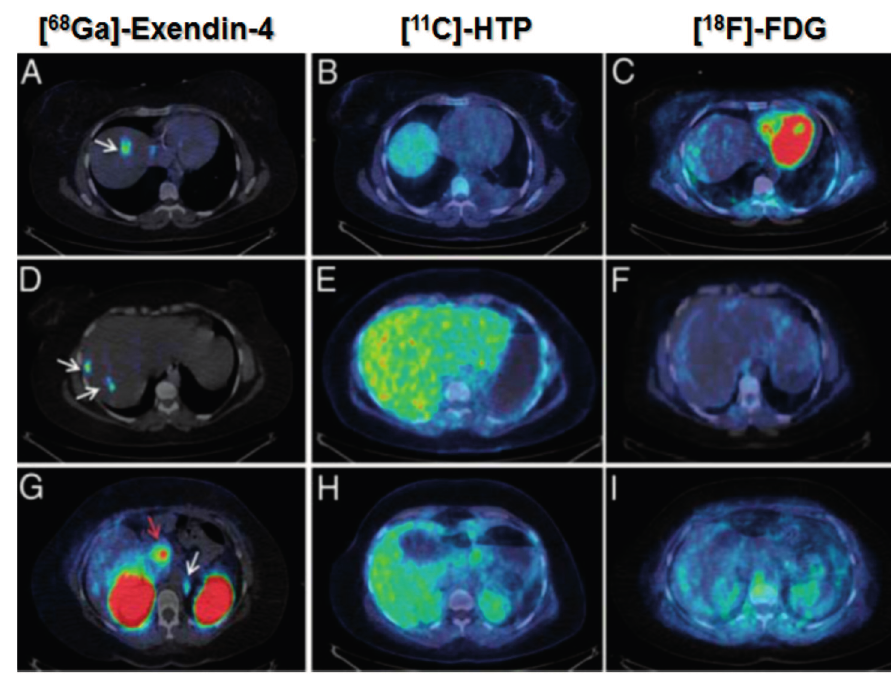
Figure 19. [ 68 Ga]Ga-DO3A-Exendin-4/PET-CT revealed several GLP-1R positive lesions (white arrows) in the liver ( A , D ) and a paraortallymph node ( G ). Beta cells in normal pancreas (red arrow) have significant expression of GLP-1R and can also be visualized by this technique ( G ). No pancreatic or hepatic lesions could be detected by PET/CT using established tumor markers such as [ 11 C]HTP ( B , E , H ) and [ 18 F]FDG ( C , F , I